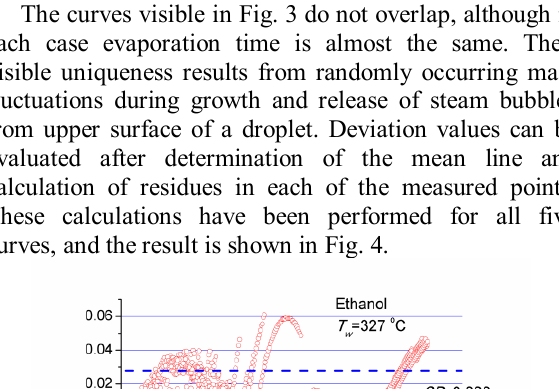
Fig. 3 . Evaporation of the ethanol droplets on the wall of the temperature T w =327 o C.